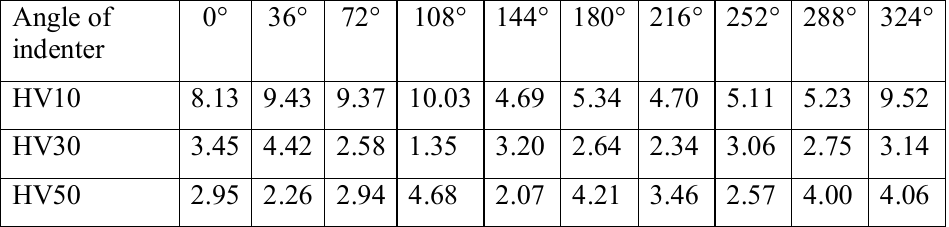
Table 1 – The results of indirect calibration values of standard deviations s HV) for individual indenter rotation angles and test forces